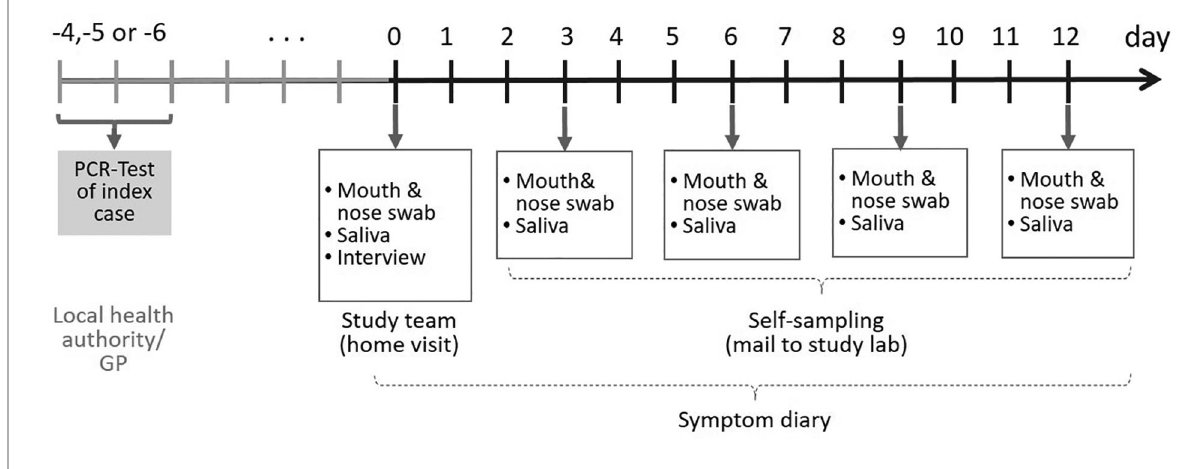
FIGURE 1 Timeline sampling scheme for bio samples taken from the participants of the COALA study (SARS-CoV-2 index cases, secondary cases and close contacts of SARS-CoV2 cases in the respective daycare center group and households). Participants were enrolled 4 – 6 days after the index case got tested. GP=general